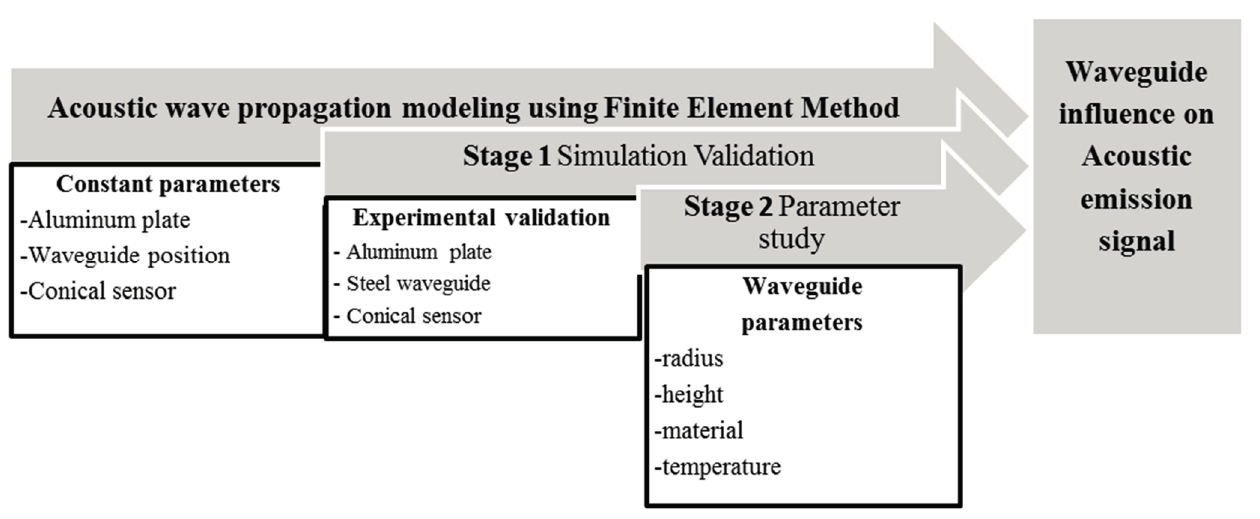
Figure 1. Overview of the present